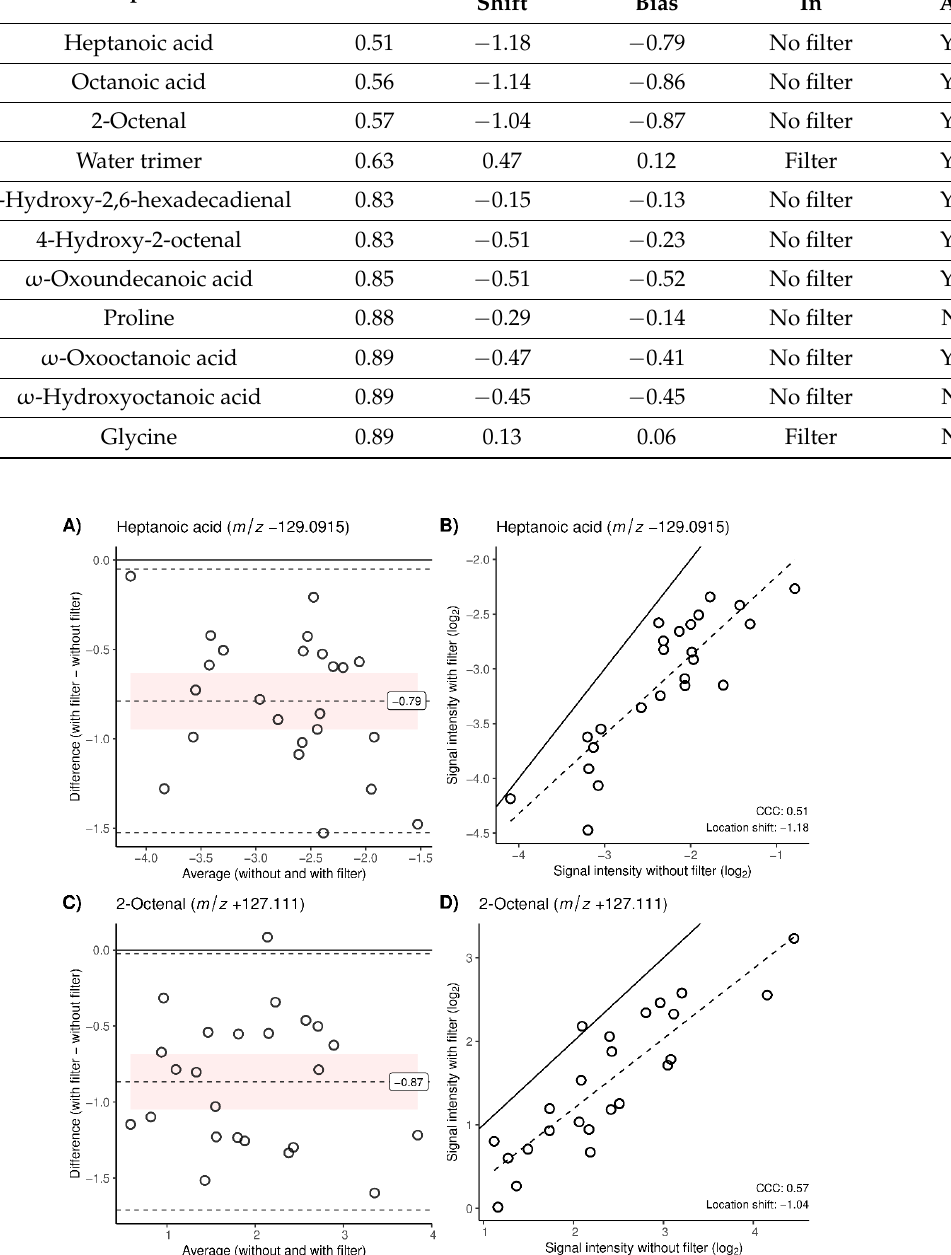
Figure 2. ( A , B ) Heptanoic acid ( m/z − 129.091) in negative ionization mode, ( C , D ) 2-octenal ( m/z +127.111) in positive ionization mode. ( A , C ): Bland – Altman plots. Horizontal dashed line in the pink area represents the bias (average of with filter to without filter differences) with its value as a label on the right. A negative value of the bias indicates signal intensity reduction with filter usage. Pink ribbon: 95% confidence interval of the bias. Top and bottom dotted lines: agreement limits, i.e., ± 1.96s, s = standard deviation of the differences. Horizontal full line (black): line of zero difference. ( B , D ): signal intensities without filter usage vs. signal intensities with filter usage for all observed pairs. Diagonal full line (black): the line of perfect agreement. Dotted line: simple linear regression for intensity values with filter usage as a function of intensity values without filter usage. Included in the bottom right corner are concordance correlation coefficient (CCC) and the location shift.